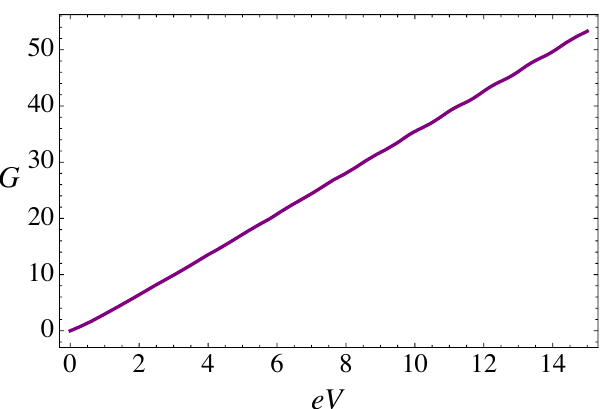
Figure 5. (Color online) Differential conductance (in units of e 2 /¯ h ), for the RDSP barrier alone, plotted as function of applied bias eV (in units of ¯ hv F / a ) for α = 3 π /4 and T = 0.2 ¯ hv F / k B a , computed from Equation (8).